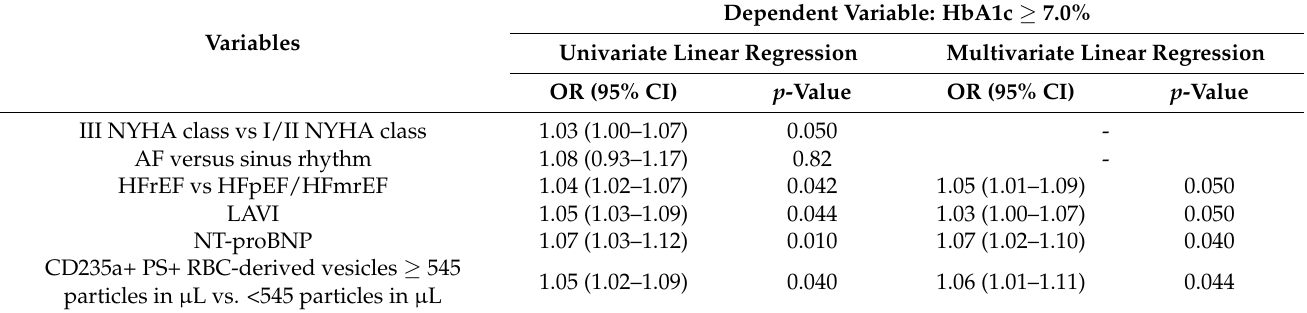
Table 2. The predictors for poor glycemic control in study population. The results of univariate and multivariate logistic regression analysis adjusted to HOMA index and BMI.